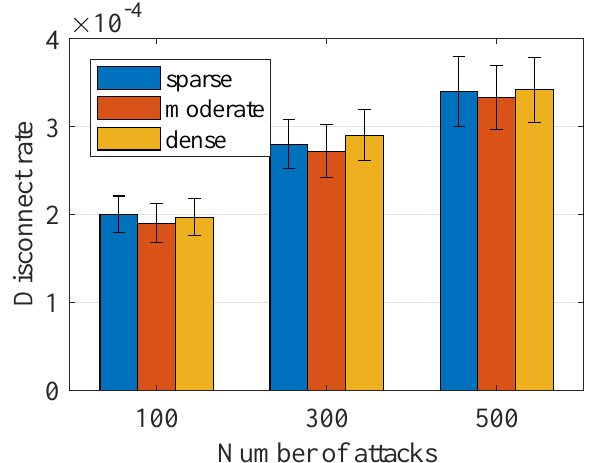
Figure 12. Performance under Replay attack.